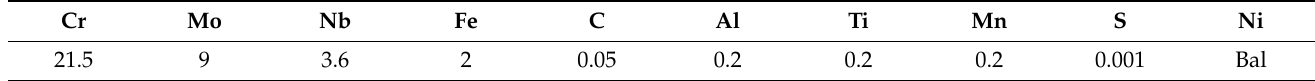
Table 1. Chemical composition of the GH3625 superalloy (mass%).